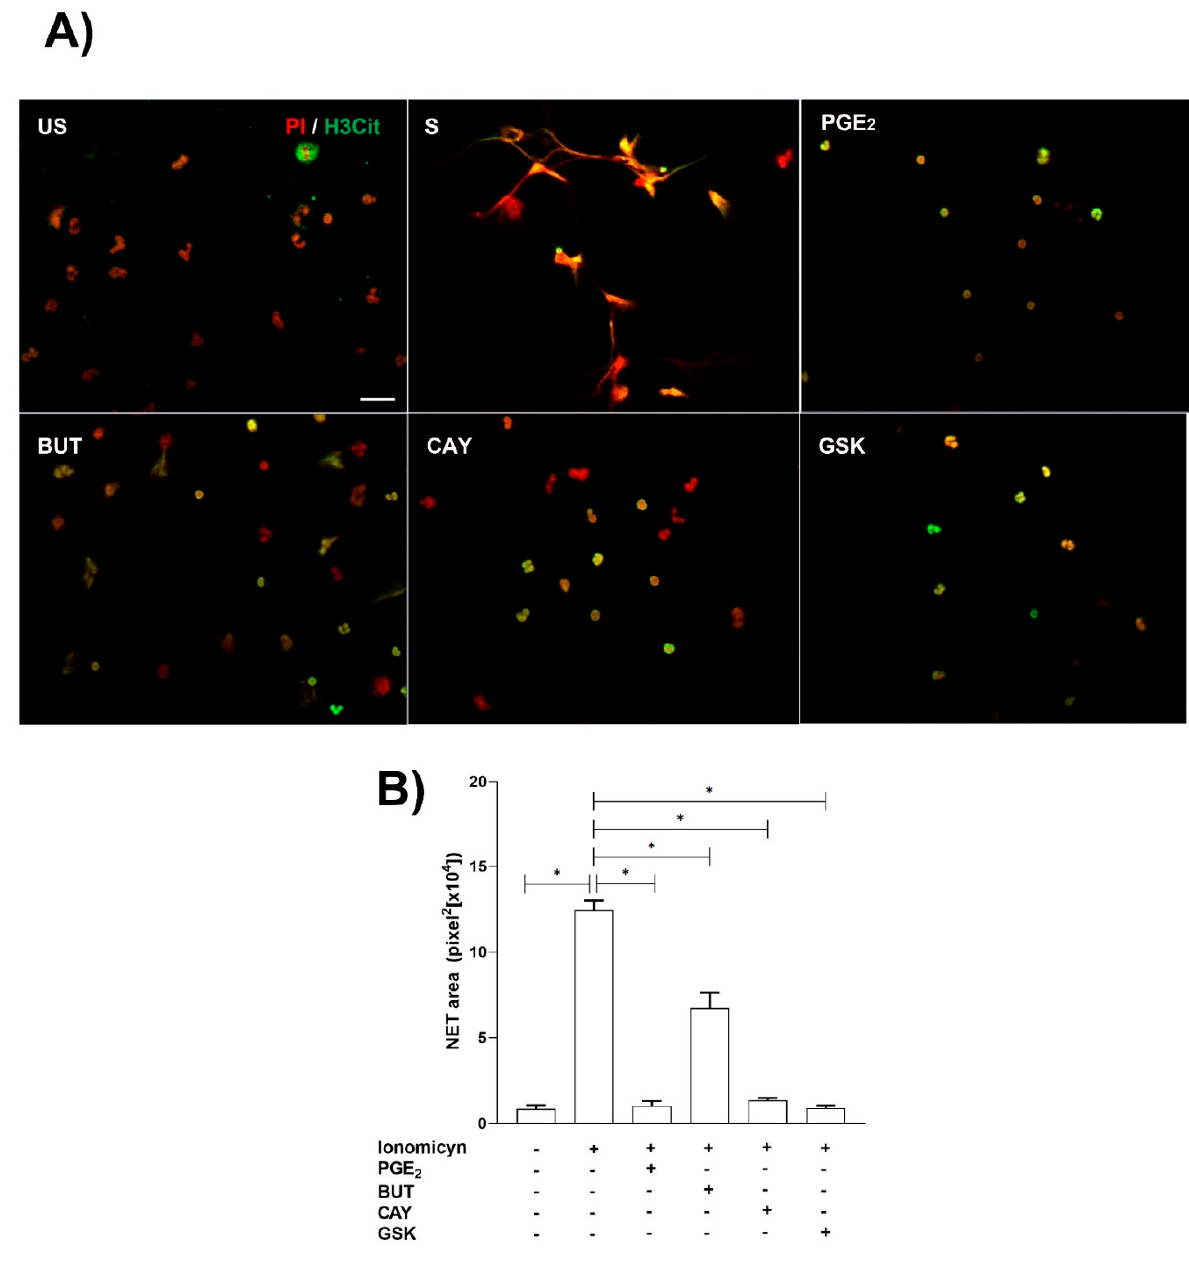
Figure 4. NET release is reduced by PGE 2 , EP2, and EP4 PGE 2 receptor agonists and GSK-484. Neutrophils were preincubated with PGE 2 (10 nM), Butaprost (BUT) (10 nM), CAY-10598 (CAY) (10 nM), and GSK-484 (10 µ M) 15 min before ionomycin stimulation (S) and stained with H3- citrullinated (H3Cit) and propidium iodide (PI). The NET area was quantified in the obtained images. Scale bar, 20 µ m ( A ). Ionomycin induced NET release, while PGE 2 reduce NET released. However, CAY and GSK-484 significantly ( p < 0.05) inhibited NET release ( B ). Bars represent the mean ± SE. * p <